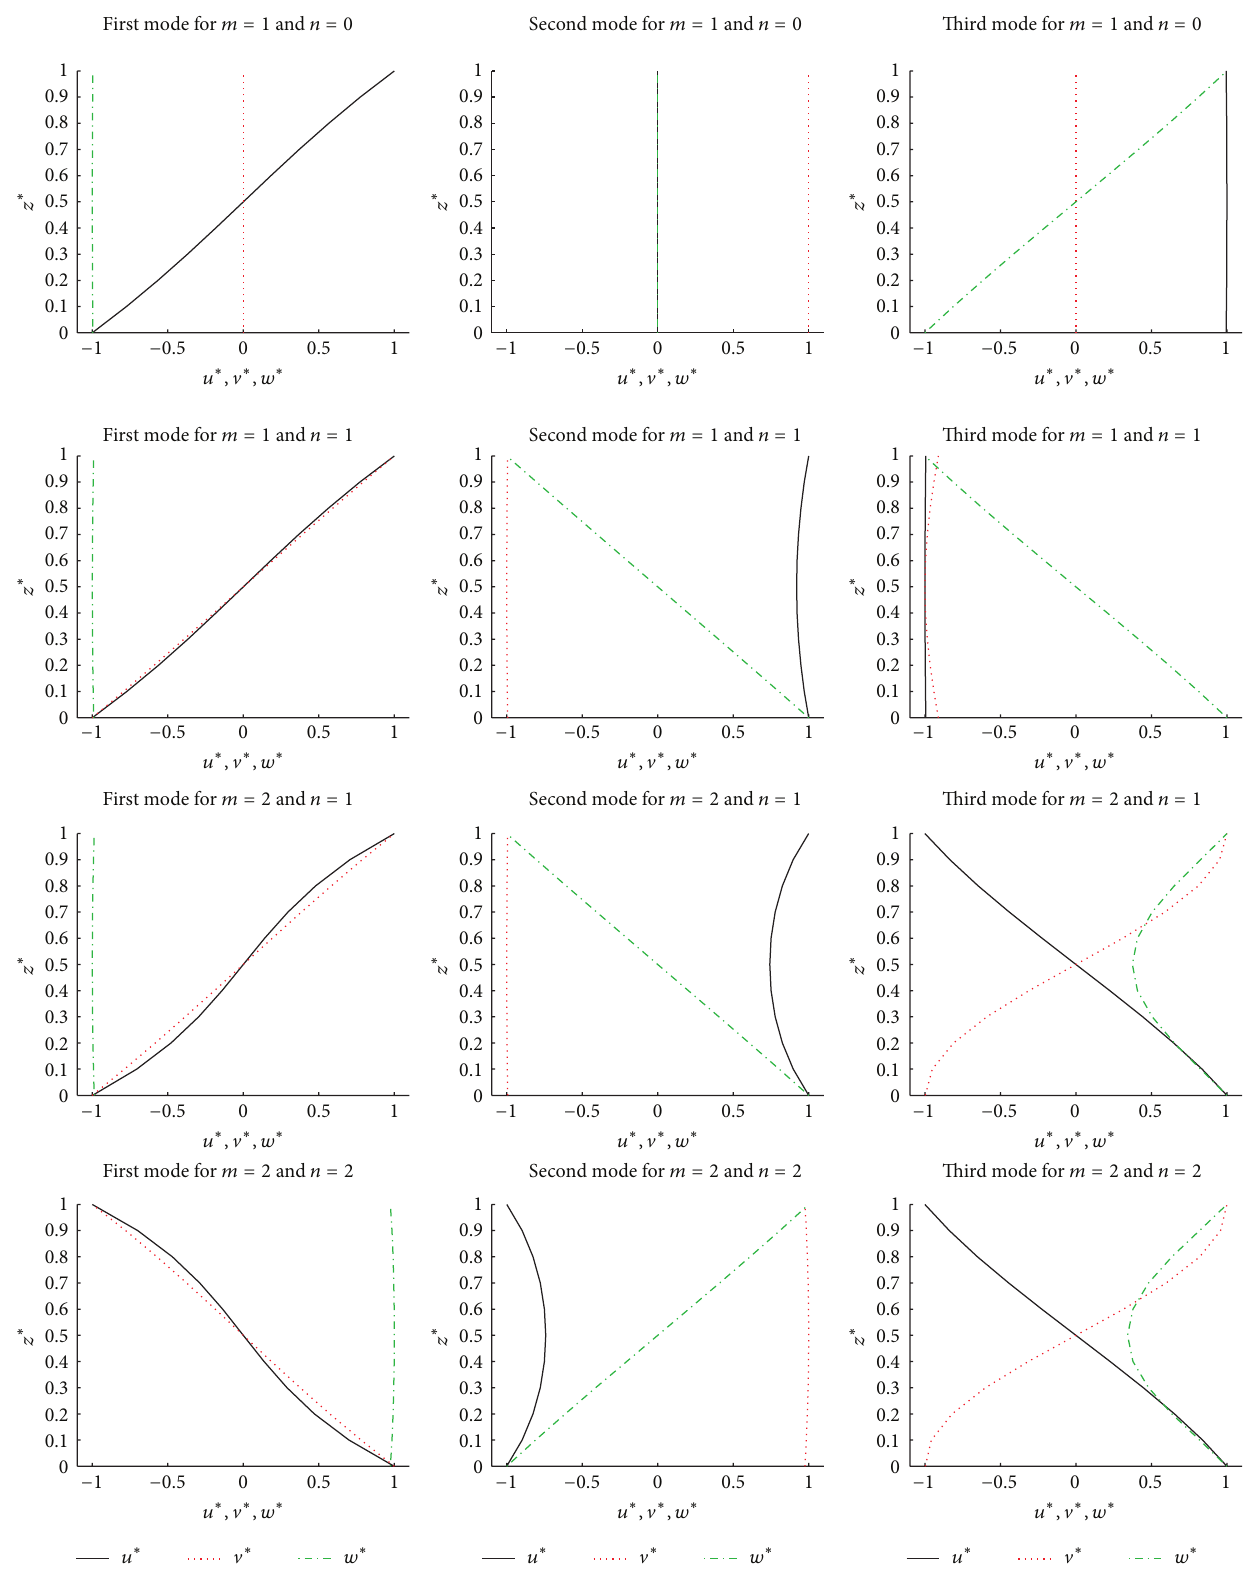
Figure 5: Benchmark 2, simply supported orthotropic square plate (𝜃 = 0 ∘ ). First three vibration modes in terms of displacement components through the thickness for thickness ratio 𝑎/ℎ = 10 and several combinations of half-wave